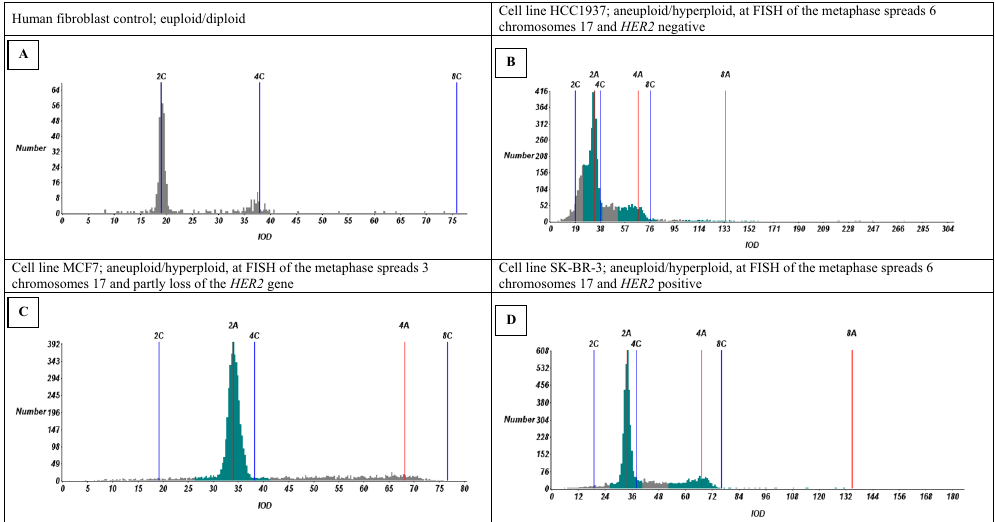
Figure 3. Cell line examples of DNA histograms of agarcyto material. IOD: integrated optical